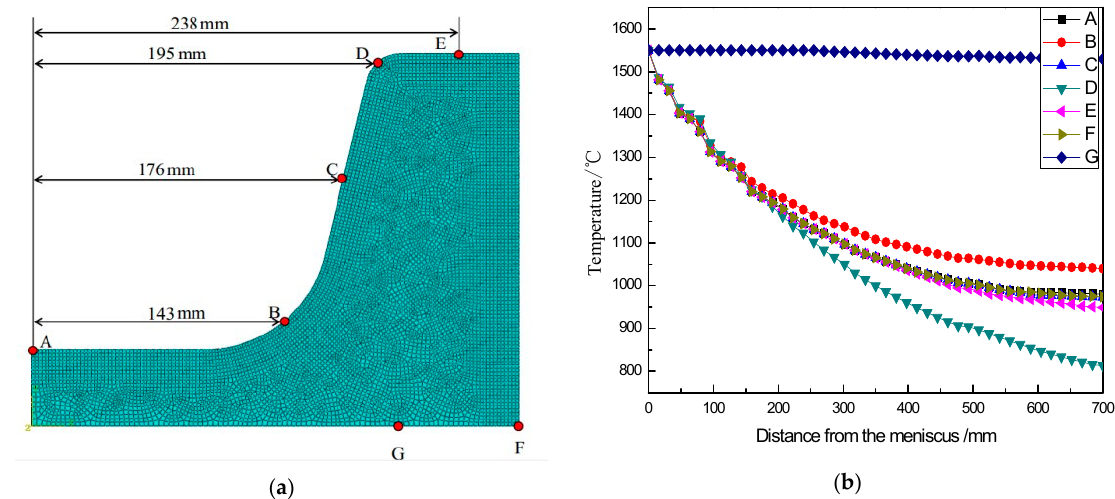
Figure 5. ( a ) Position of the typical points and ( b ) Temperature curve of typical points at different distances from the meniscus.